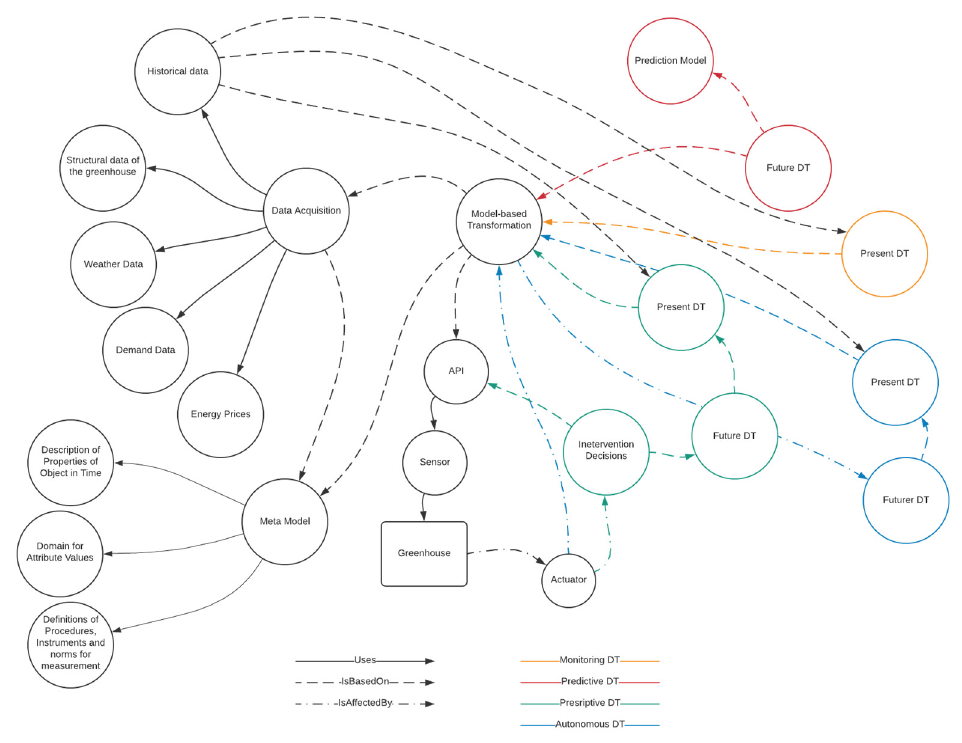
Figure 1. Network graph of 4 DT stages, including monitoring, predictive, prescriptive, and autonomous.